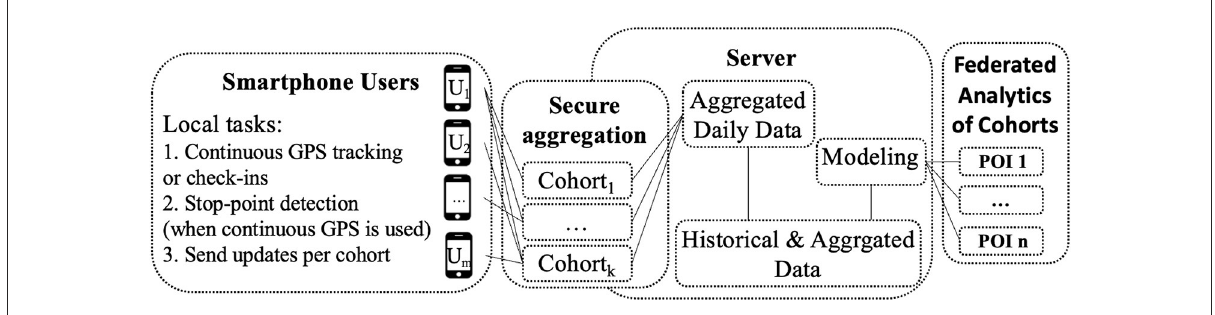
FIGURE3 Proposed method for privacy-aware federated analytics of cohorts for smart